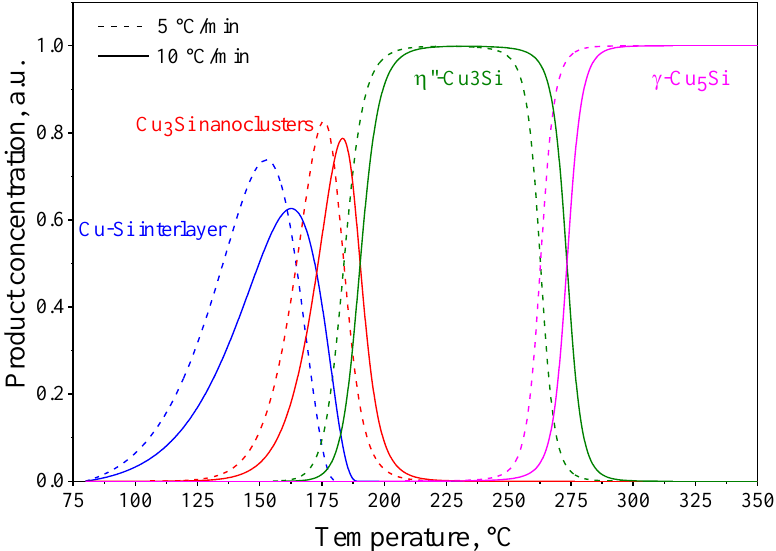
Figure 10. Concentration curves of different stages of the phase formation in the (Cu/a-Si) 30 thin films calculated using the results of thermokinetic modeling: heating rate of 5 °C/min (dashed lines) and 10 °C/min (solid lines).